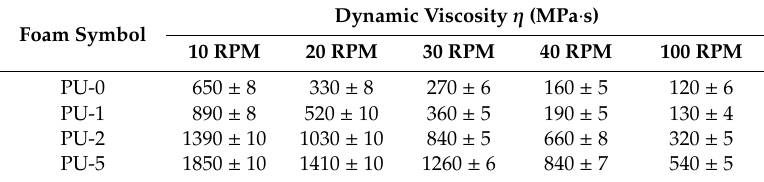
Table 2. The results of the dynamic viscosity of polyol mixtures measured in the function of shear